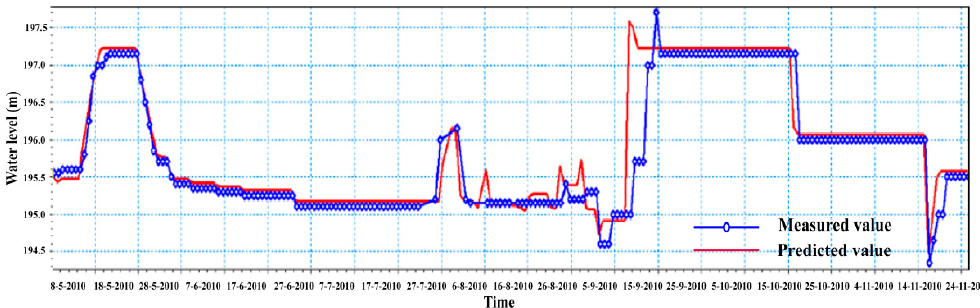
Figure 2. Simulated result of the water level at Cross Section A.